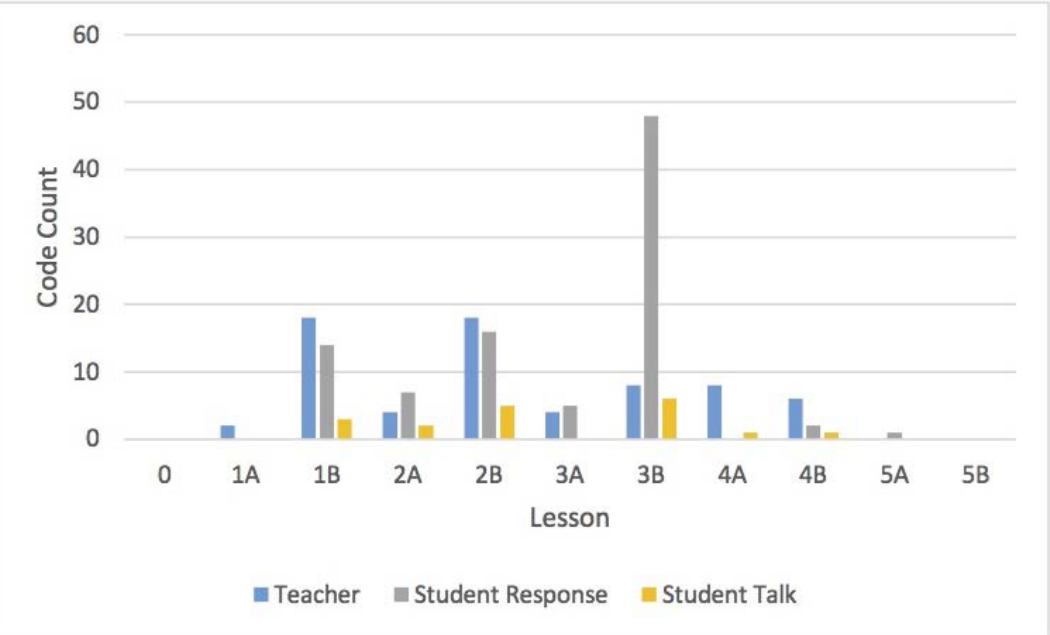
Figure 4. Instances coded as being directly a part of the “Learn” stage of the